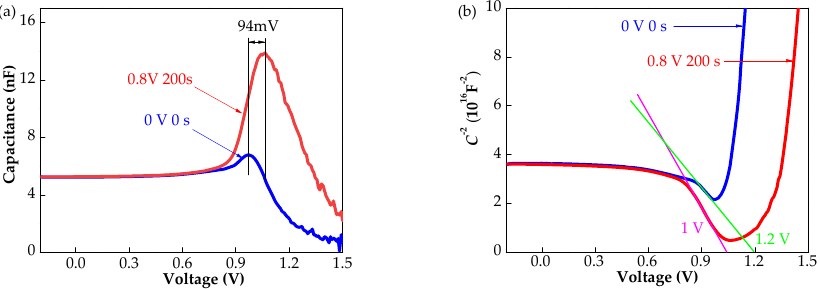
Figure 5. Impedance spectrum of electric field modulated quasi ‐ 2D perovskite solar cells ( a ) The C–V spectra. ( b ) The corresponding Mott–Schottky ( C − 2 ‐ V ) curves. spectra. ( b ) The corresponding Mott–Schottky ( C − 2 - V )